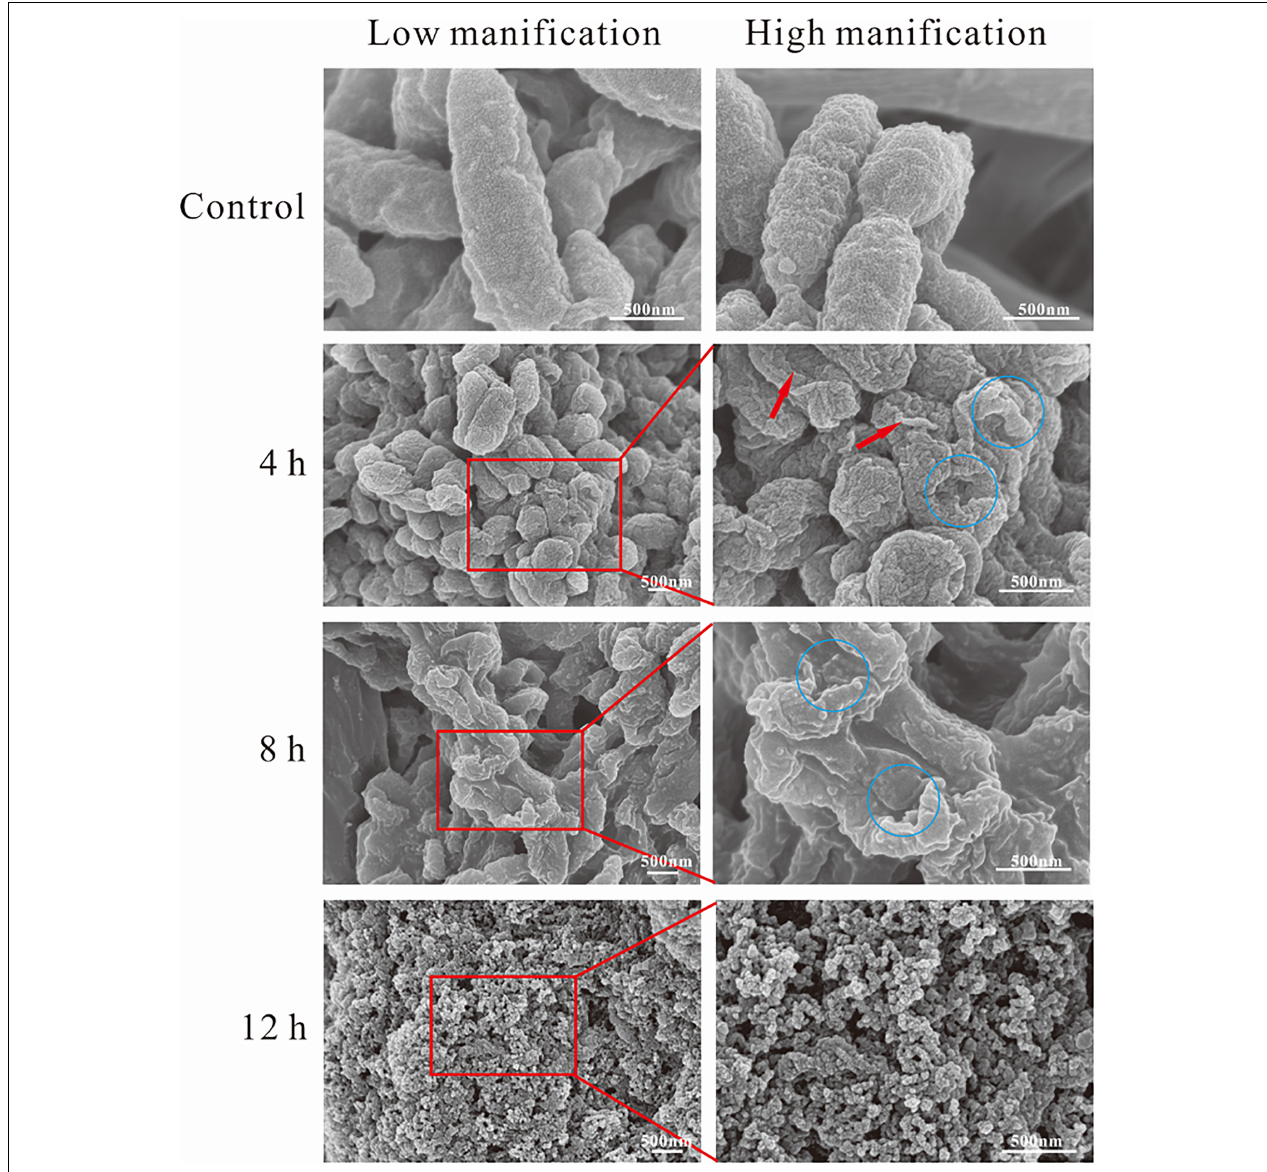
FIGURE 3 | Scanning electron microscopy (SEM) photography of A. hydrophila planktonic cell. (Control) Untreated group; (6, 12, and 18 h) bacteria treated by SMEO at 1 × MIC for 6, 12, and 18 h, respectively. The red arrows and blue circles indicate wrinkled surfaces and cell collapse.